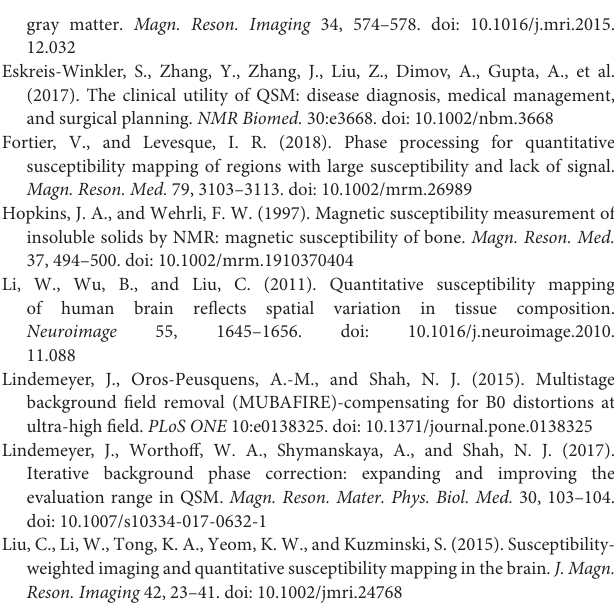
maps of all simulation steps are